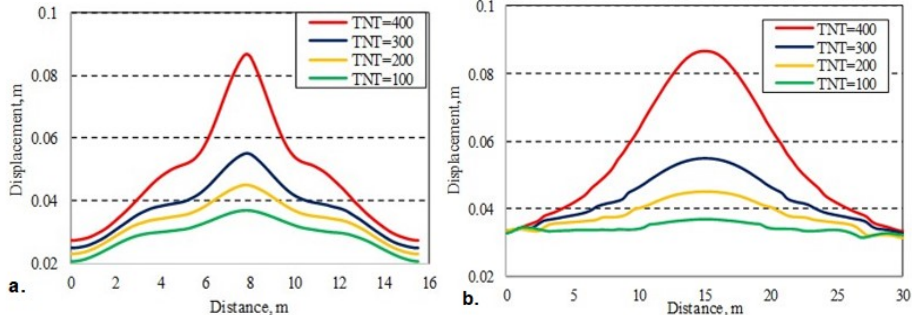
Figure 17: a. Maximum displacement along path 1 at .05 sec. b. Maximum displacement along path 2 at .05 sec.